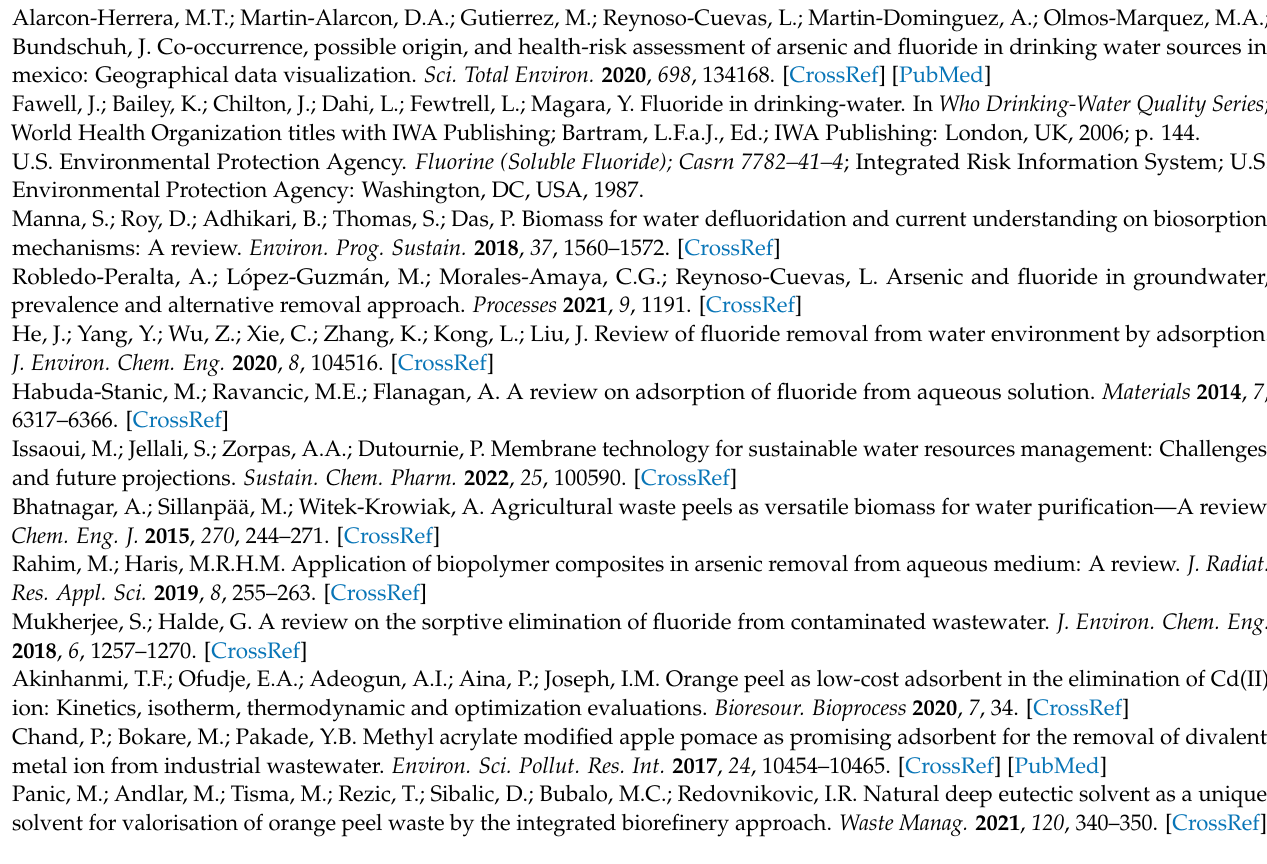
Figure S2: Relationship between the Zr3d binding energy and the Pauling charge in the Zr species of Pantano and Brow [67] and of the present study; Table S1: Summary of parameters analyzed by the BET method, Table S2: Physico-chemical characterization of groundwater from the state of Durango, M é xico, Table S3: Peak Deconvolution peaks on bioadsorbents before and after